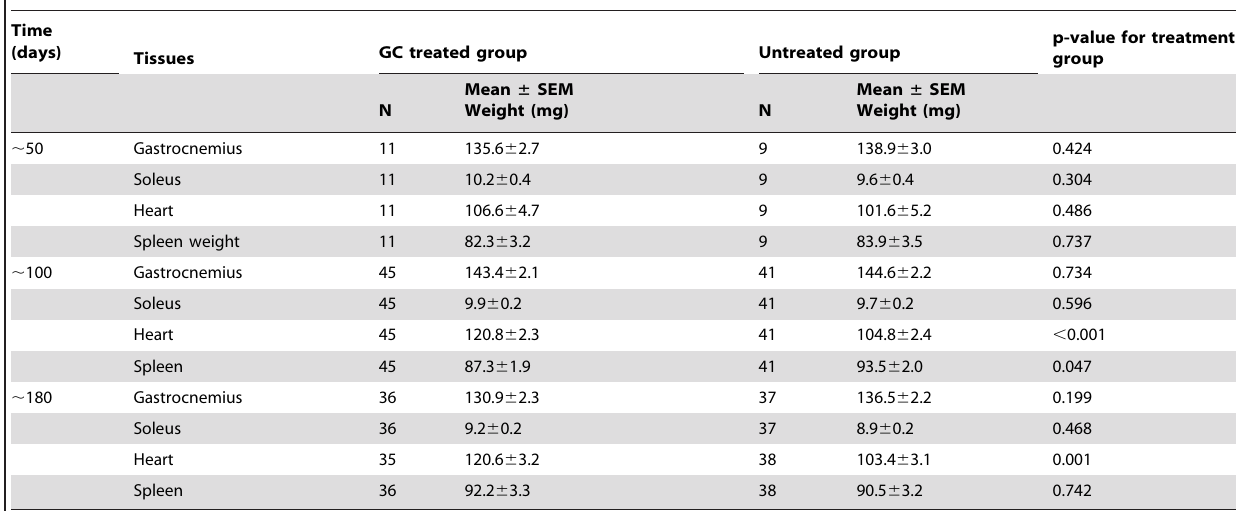
Table 1. Weight of muscles and spleen in untreated and GC-treated mice.